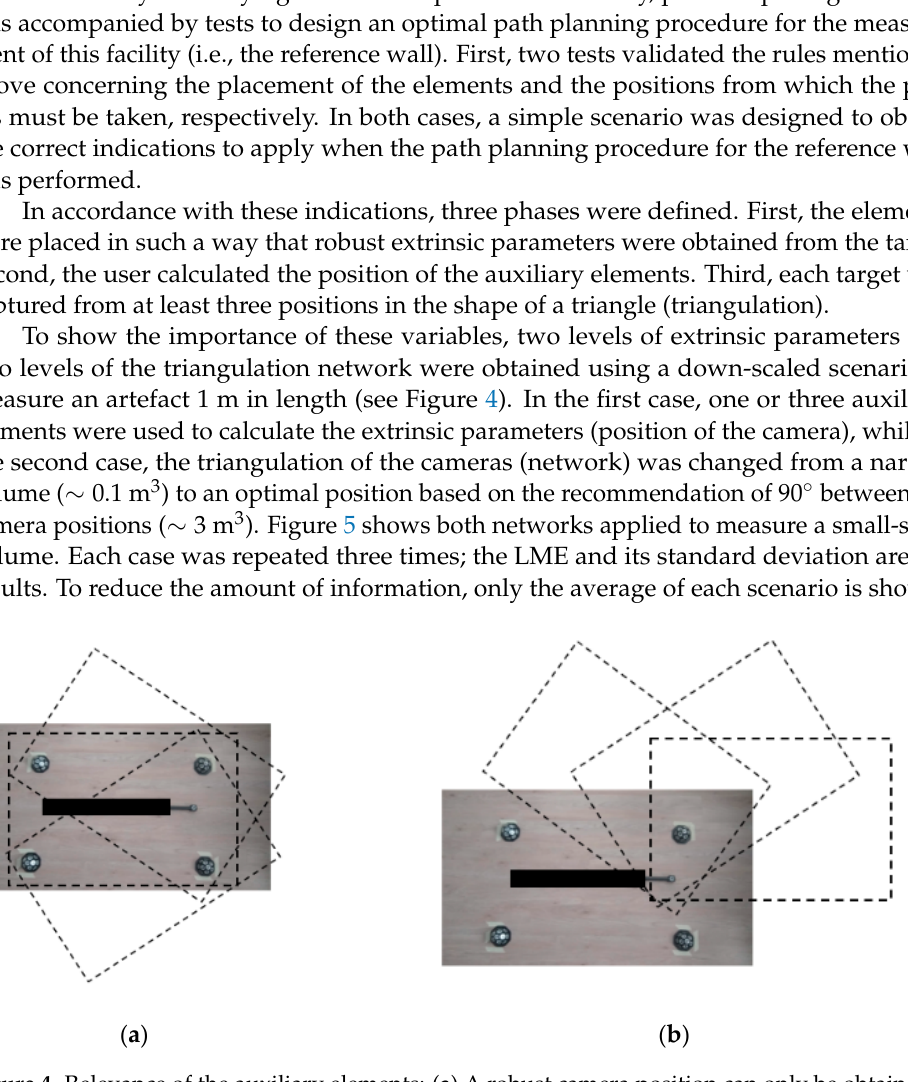
7 Figure 3. ( a ) The igloo-shaped auxiliary element with coded markers. At the bottom, there are three magnets for attaching the element to ferromagnetic workpieces. ( b ) A retroreflective target on a hemisphere for use with the nests on the reference wall (target diameter: 20 mm ). ( c ) Cross- point providing the coordinate system’s origin. ( d ) Scale bars with coded markers ensure the cor-